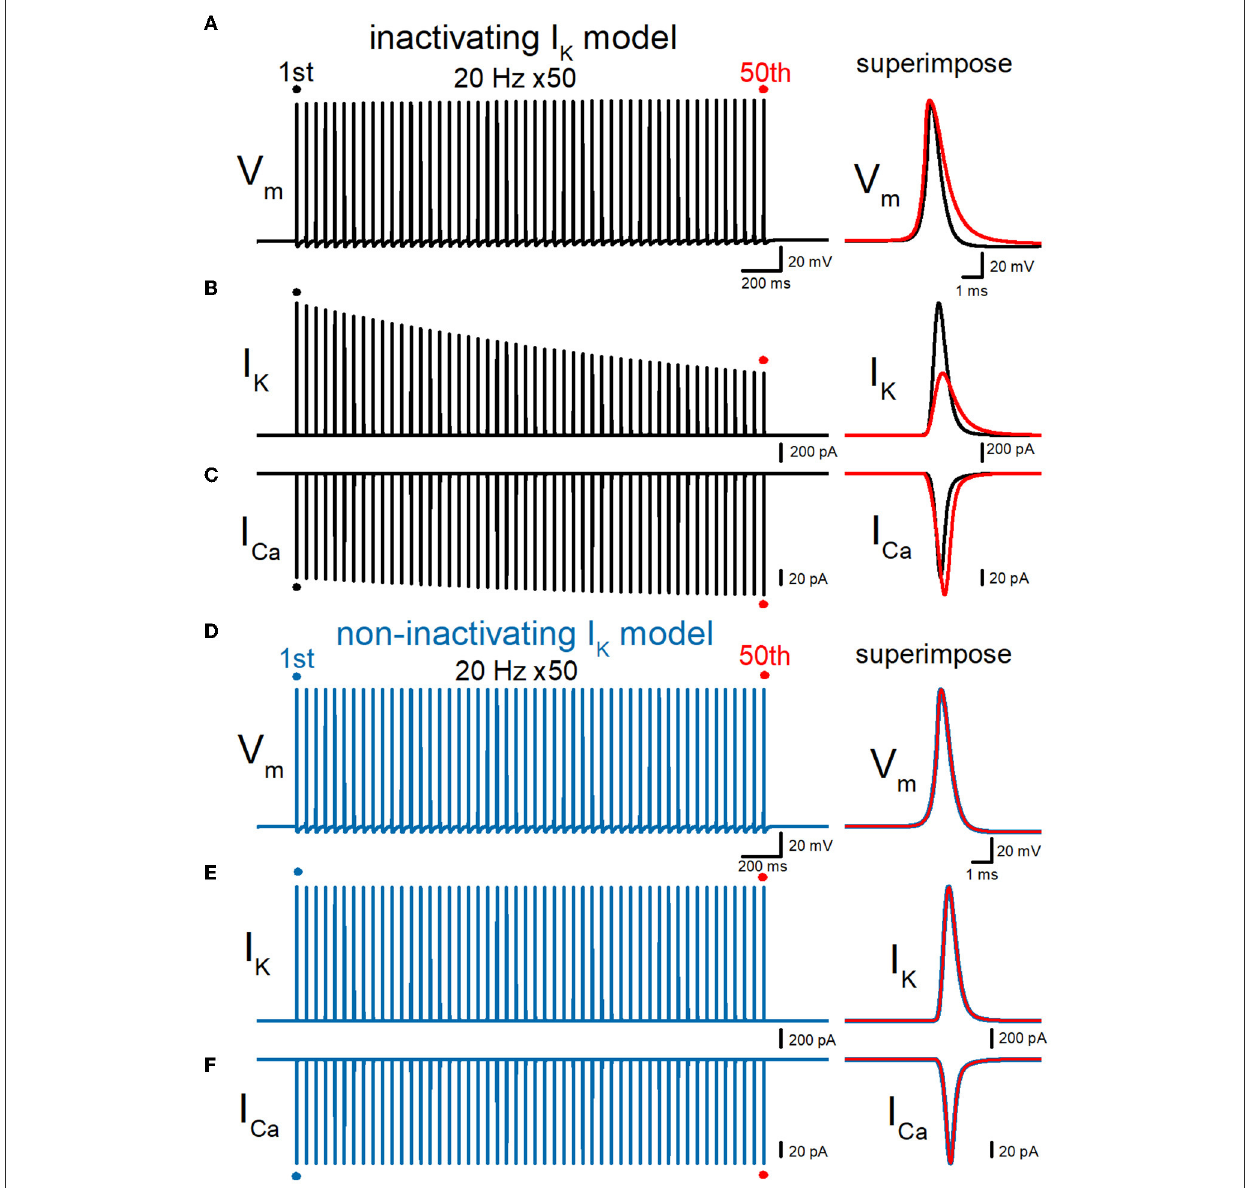
FIGURE3 Effects of repetitive stimuli on action potentials, axonal I K , and presynaptic I Ca simulated with inactivating and non-inactivating axonal K + channels. (A) Simulated propagating action potentials at the mossy fiber bouton (V m ) elicited by repetitive stimuli of 50 times at 20Hz in the inactivating I K model. (B) Axonal K + current elicited by the repetitive action potentials (I K ) in inactivating I K model. (C) Ca 2 + currents (I Ca ) elicited by axonal action potentials during the repetitive stimuli in inactivating the I K model. (D) Simulated propagating action potentials at the mossy fiber bouton (V m ) elicited by repetitive stimuli of 50 times at 20Hz in the non-inactivating I K model. (E) Axonal K + current elicited by the repetitive action potentials (I K ) in the non-inactivating I K model. (F) Ca 2 + currents (I Ca ) elicited by axonal action potentials during the repetitive stimuli in the non-inactivating I K model. In each right panel, the responses to the 50th stimulus (red traces) were superimposed with that elicited by the 1st stimulus (black or blue traces) for